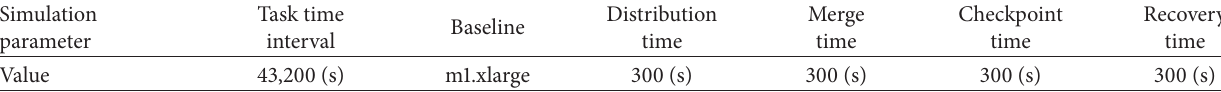
Table 2: Parameters and values for